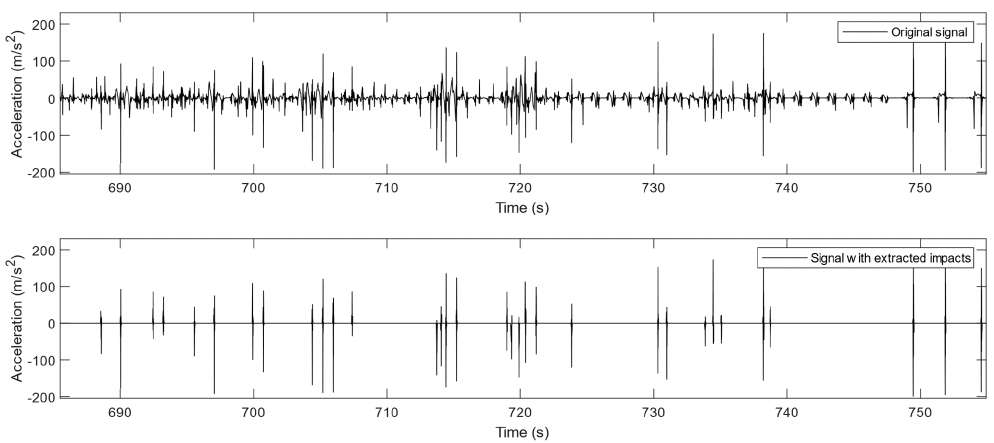
Figure 12. The graph on the top shows the original resampled acceleration data. The graph on the bo tt om shows the same signal with the extracted impacts.